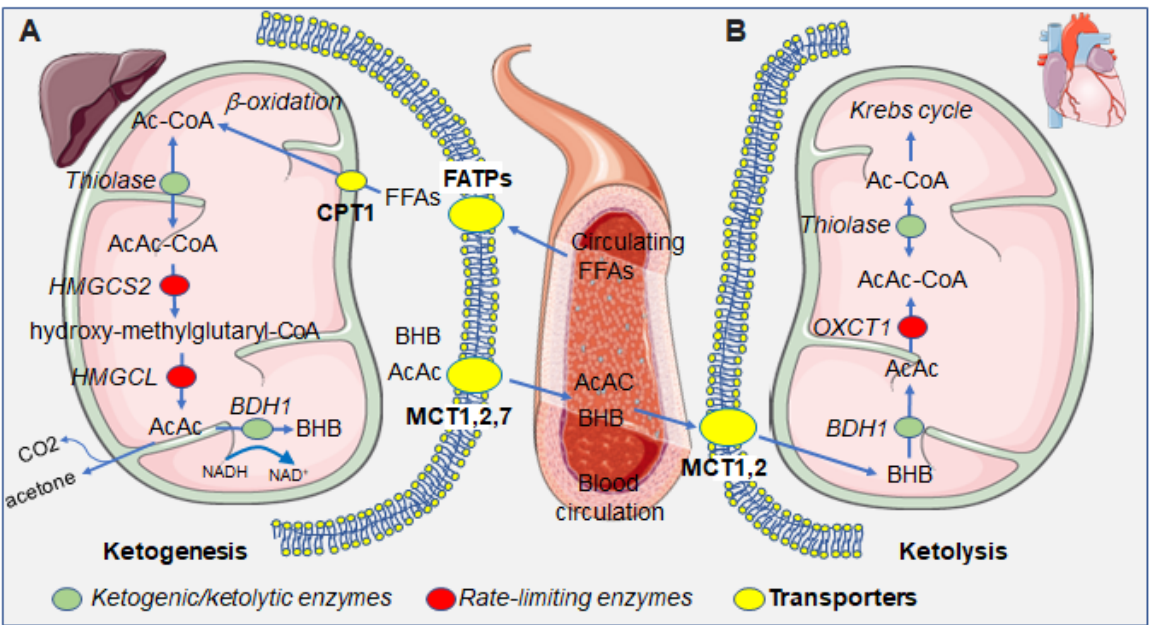
Figure 1. Summarizing scheme of the metabolism of ketone bodies in the hepatic and extrahepatic compartments. ( A ) In the liver, free fatty acids (FFAs) enter into the hepatocytes’s cytoplasm and then mitochondria, via fatty acid transporters (FATPs) and carnitine palmitoyltransferase I (CPT1), which serve as substrates for ketogenesis, leading to the production of the ketone bodies, BHB, AcAc, and the byproduct acetone. Ketone bodies that are exported from hepatocytes through the monocarboxylate transporters (MCTs) 1, 2, and 7. ( B ) In the heart, circulating ketone bodies enter cardiomyocytes through MCTs 1 and 2 and serve as substrates for ketolysis, ultimately yielding Ac-CoA which enters the Krebs cycle. Green dots represent enzymes taking part in both ketogenesis and ketolysis; red dots represent rate-limiting enzymes specific for either ketogenesis or ketolysis; yellow dots represent transporters, at the cellular or mitochondrial membrane. Abbreviations: Ac-CoA, acetyl coenzyme A; AcAc-CoA, acetoacetyl coenzyme A; AcAc, acetoacetate; BHB: β -hydroxybutyrate, FFAs, free fatty acids; HMGCS2 : 3-hydroxy-3-methylglutaryl-CoA-synthase 2, HMGCL : hydroxymethylglutaryl-CoA lyase; BDH1 , β -hydroxybutyrate dehydrogenase; OXCT1 , 3-oxoacid CoA-transferase 1.